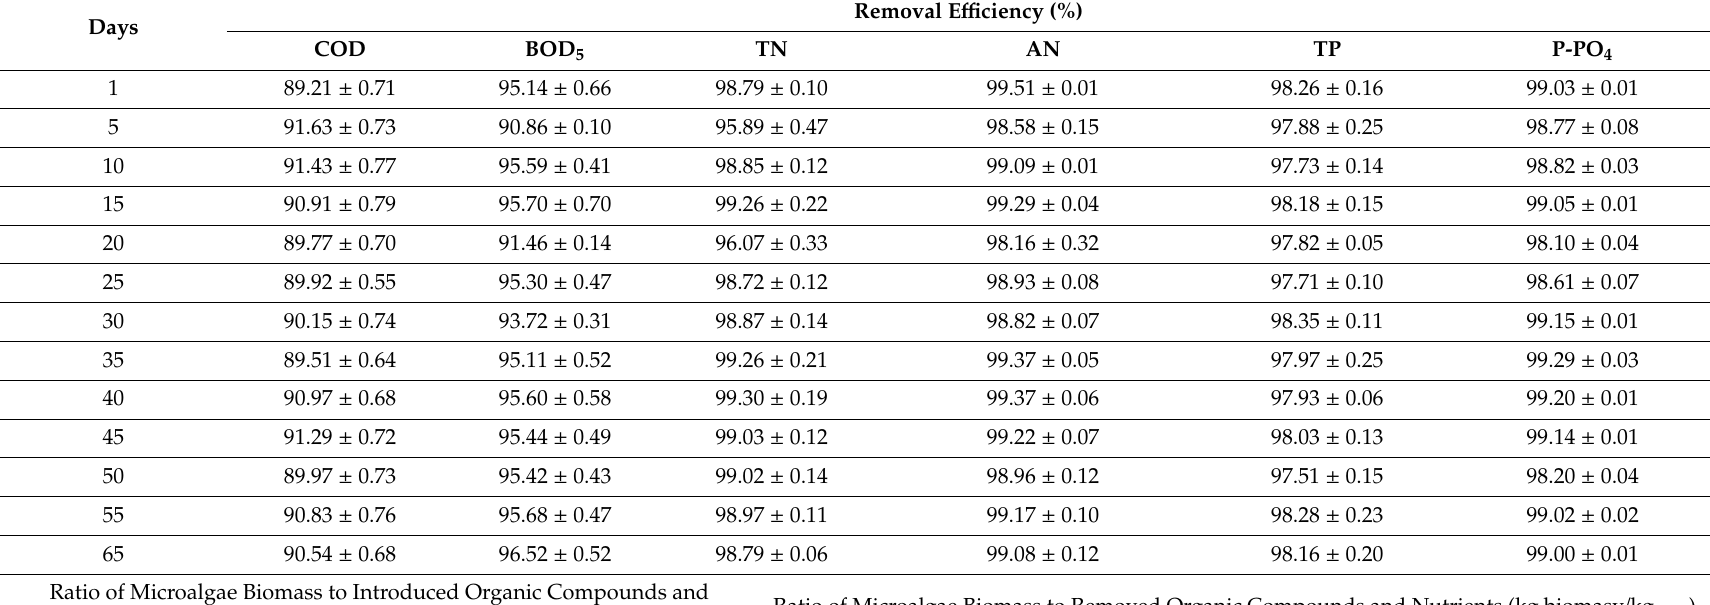
Table 4. The e ffi ciency of compounds removal and their use for the microalgae biomass growth.